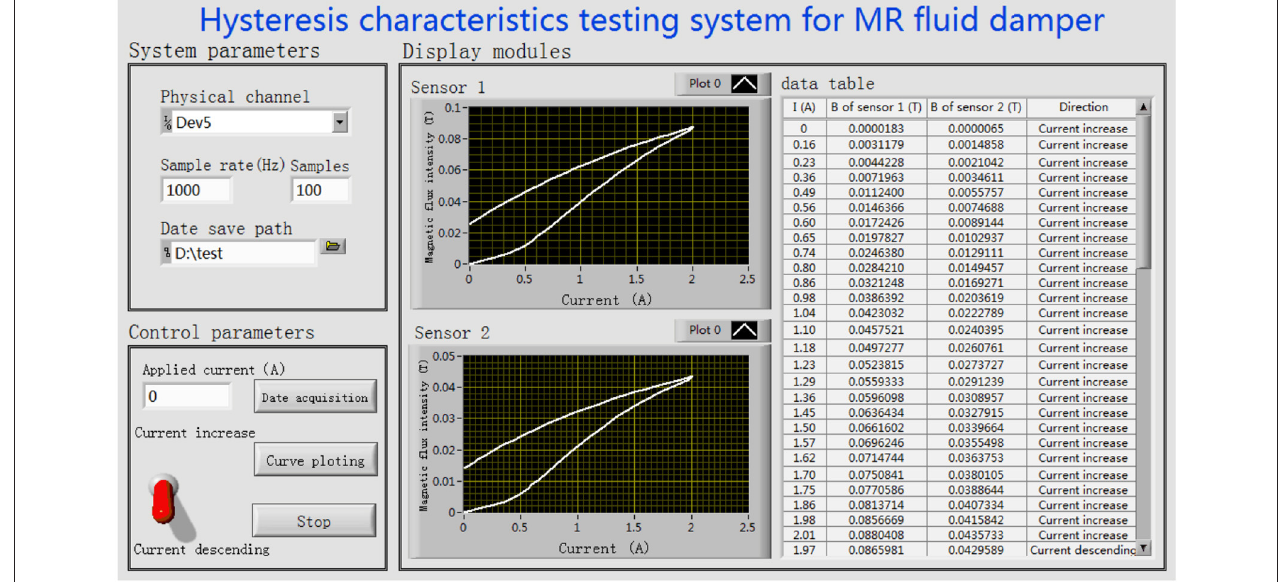
FIGURE 5 | Interface of hysteresis testing system for MR fluid damper utilizing LabVIEW.